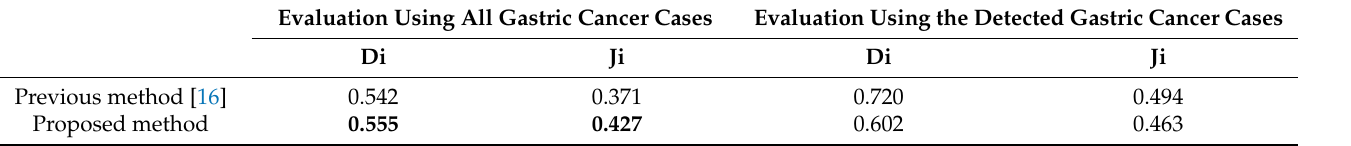
Figure 6. Examples of false positive reduction: ( a , b ) false positives correctly eliminated by the proposed method; ( c , d ) FPs that were not eliminated by the proposed method; ( e , f ) gastric cancer lesions eliminated by false positive reduction. Arrows indicate the labeled regions. Table 3. Evaluation results of Di and Ji for cancer